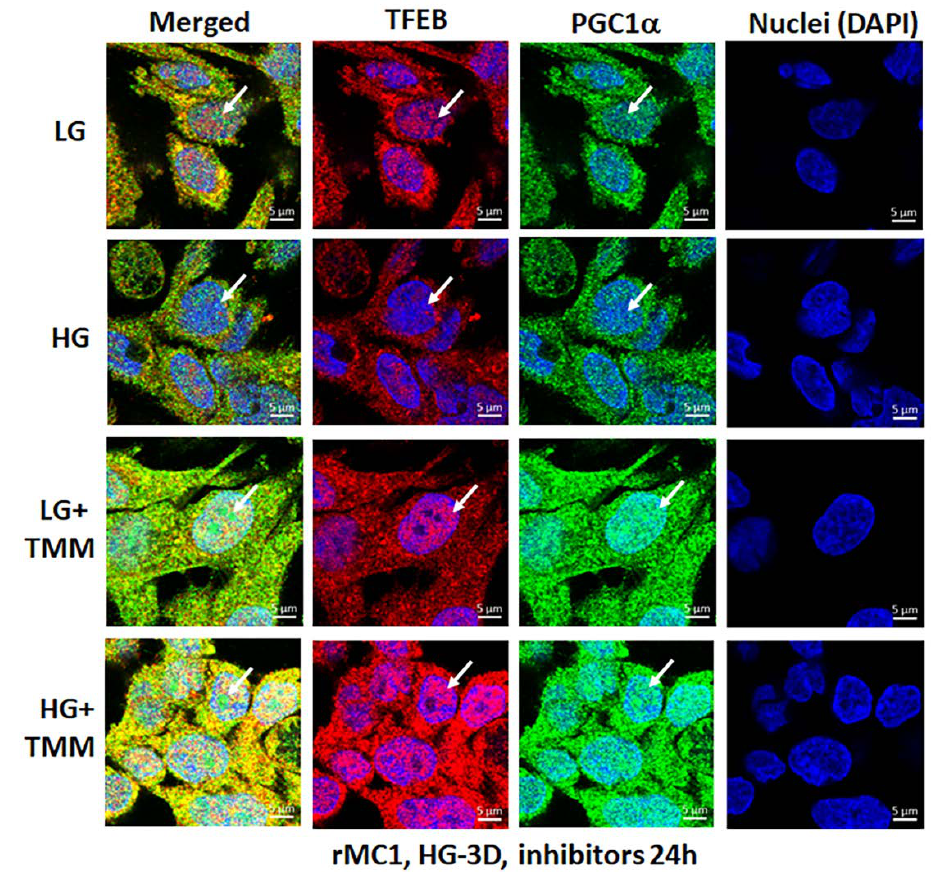
Figure 9. HG reduces transcription factor TFEB and PGC1 α nuclear translocation in rMC1. Incubation of rMC1 with HG for 3 days reduces nuclear localization of both transcription factors, TFEB (red) and PGC1 α (green) more than in LG (upper two panels). Nuclei is counter stained with DAPI (Blue). Interestingly, triple combination drug treatment (TMM) for 24 h, before ending the experiment, increases TFEB and PGC1 α nuclear localization both in LG and HG, suggesting lysosomal and mitochondrial gene transcription and biogenesis. A representative of n = 3 in fixed-cell confocal imaging, captured at 630× magnification, in a Zeiss confocal microscope.